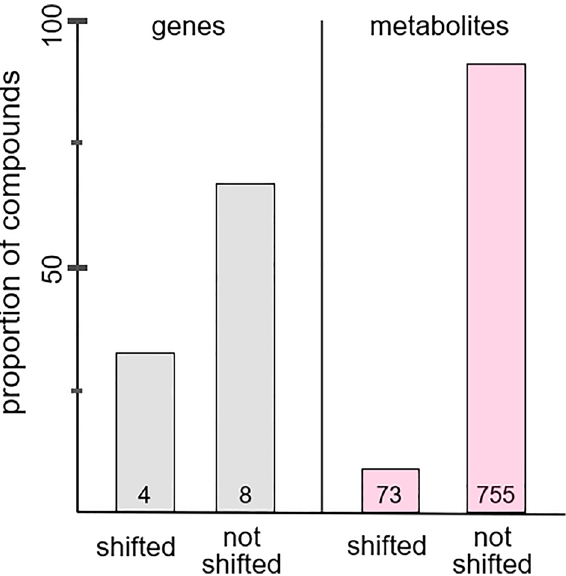
Figure 7. Proportion of shifts in day–night pattern in response to ALAN. Shown are proportions of genes (grey) and metabolites (red) whose levels were, or were not, significantly impacted by the interaction of sampling time and ALAN